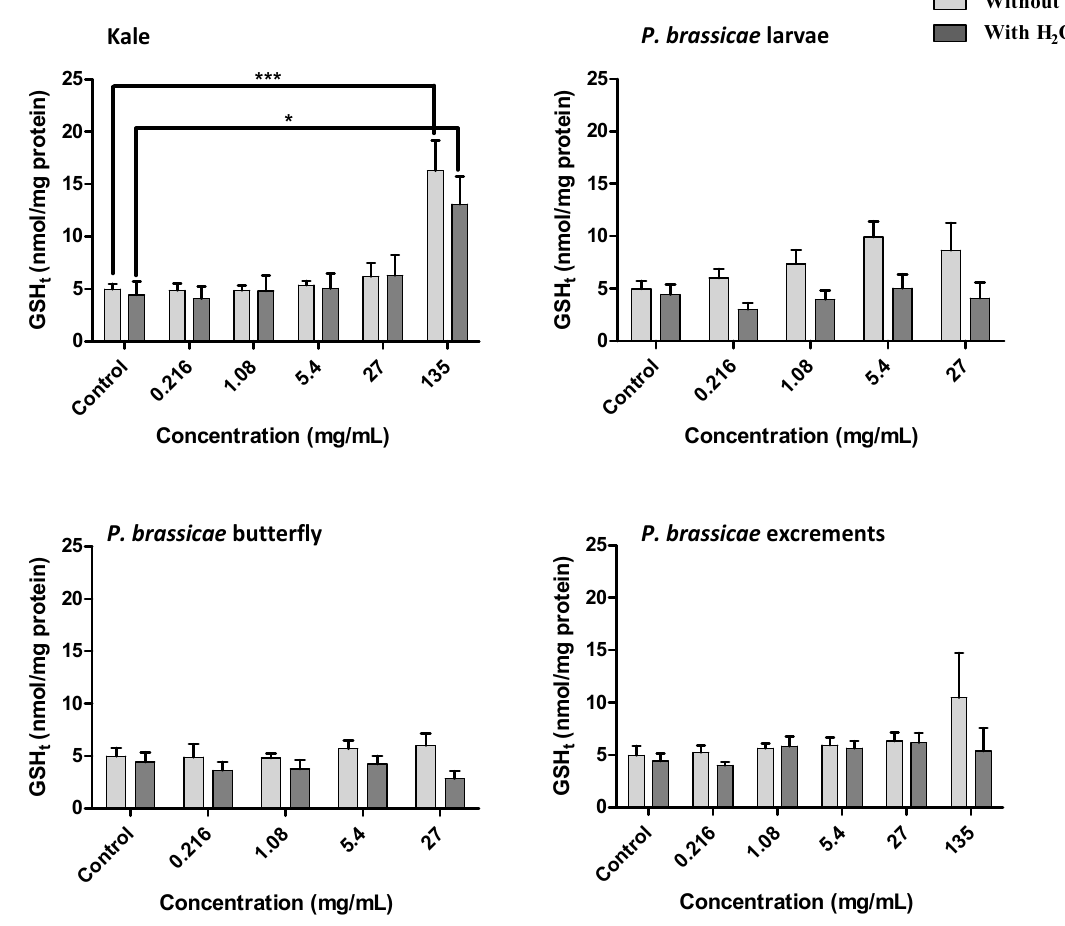
Figure 7. Effect of B. oleracea var. acephala and P. brassicae materials methanolic extracts on GSSG/GSH of V79 cells, after 24 h treatment, with and without H t oxidative stress. Values show mean ± SE (n = 4). Mean values were significantly different compared with the respective control ( * p < 0.05 and ** p <